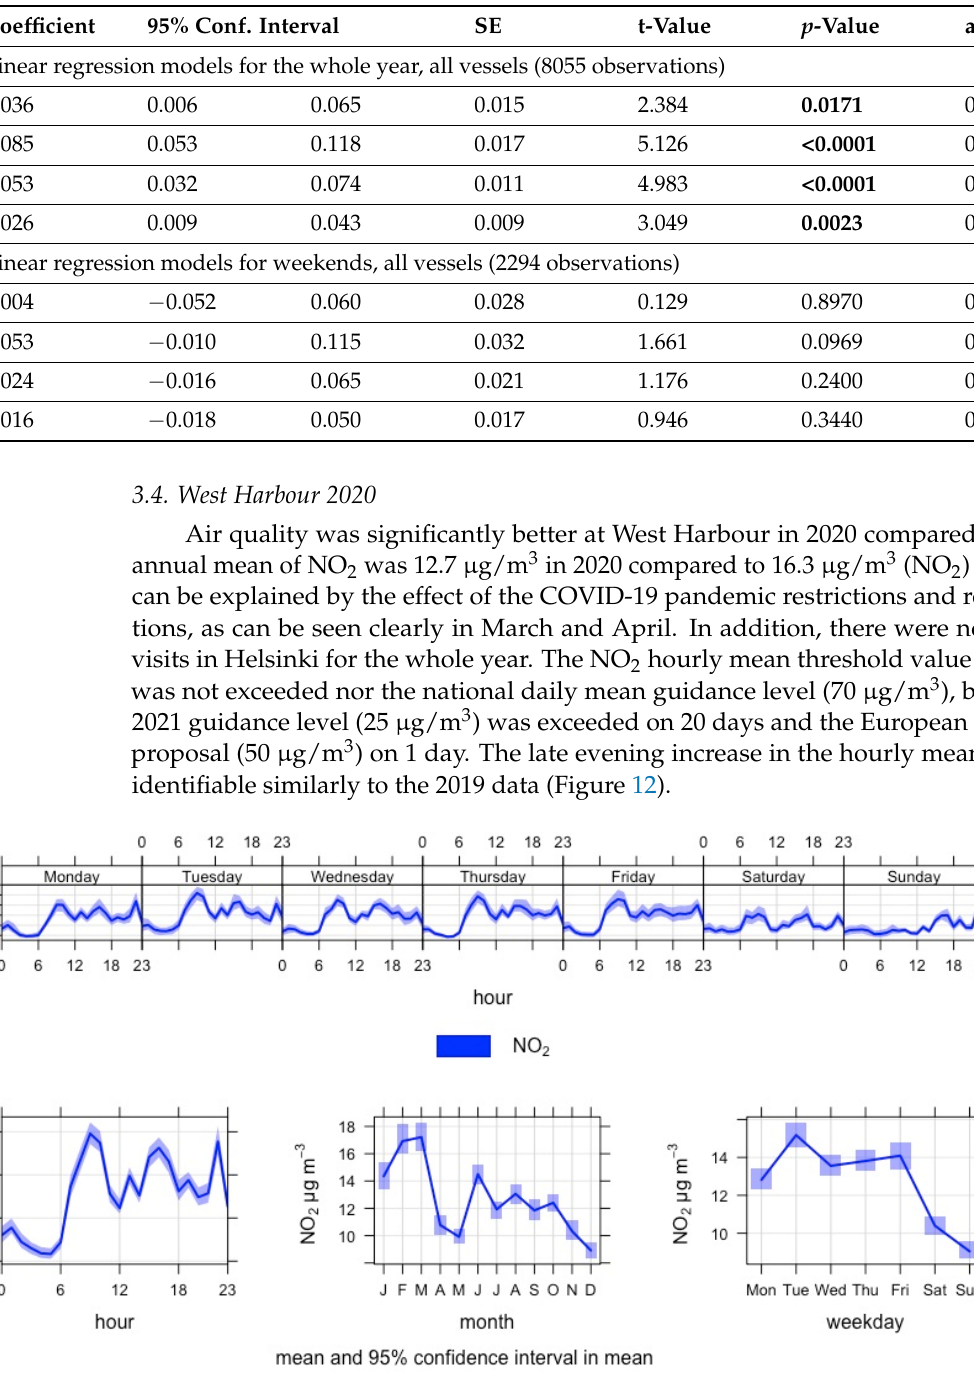
Figure 12. Time variation plot of NO 2 concentration in West Harbour in 2020.